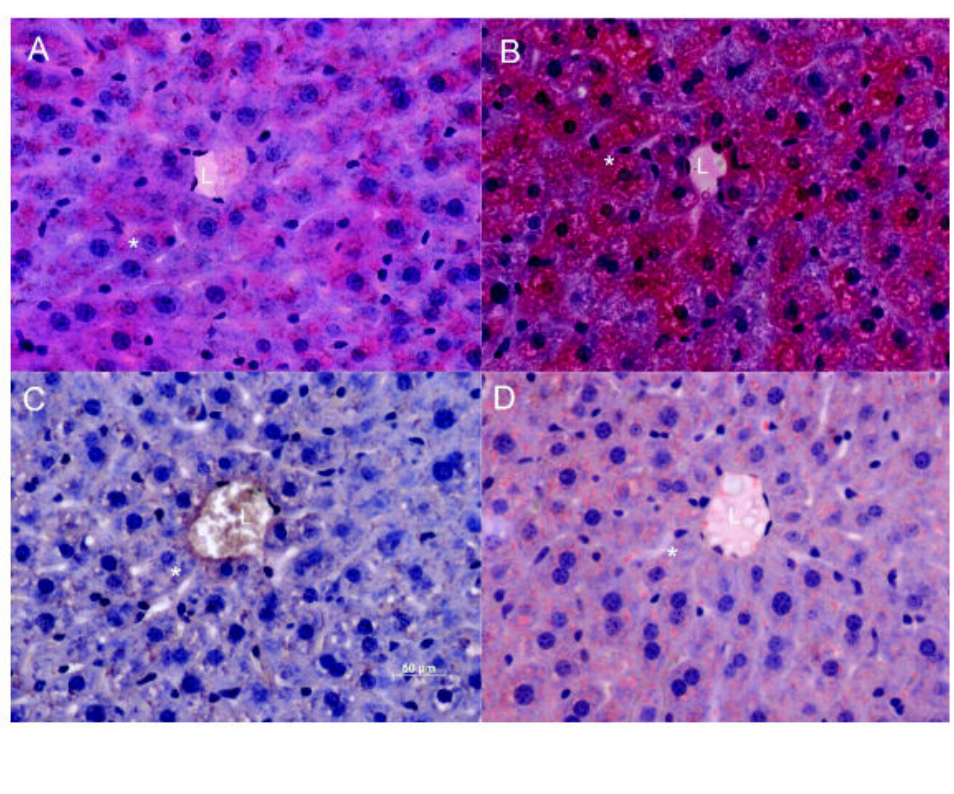
Figure 1. HFD leads to enhanced micro vesicular lipid droplets in livers. Panels A and B: Sections were stained with Hematoxylin and Eosin (H and E). Panels C and D: Oil red O staining shows and HFD livers have more areas marked with this dye in regions near the lumen of vessels. “L” indicates the lumen, and a sample hepatocyte is marked with an asterisk. Images are representative of serial sections from 6 livers per